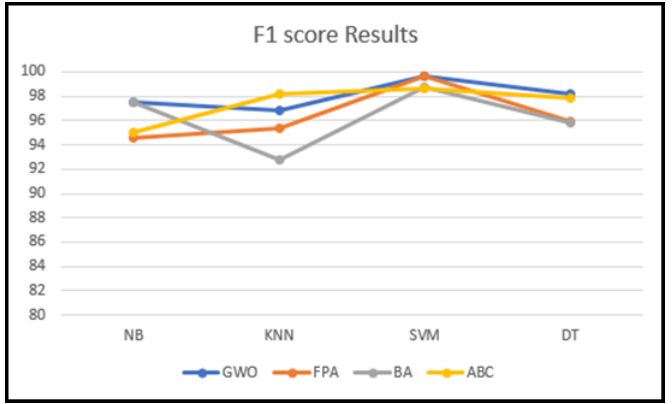
Figure 5. Comparison of F1 score results between proposed models on PBC dataset.